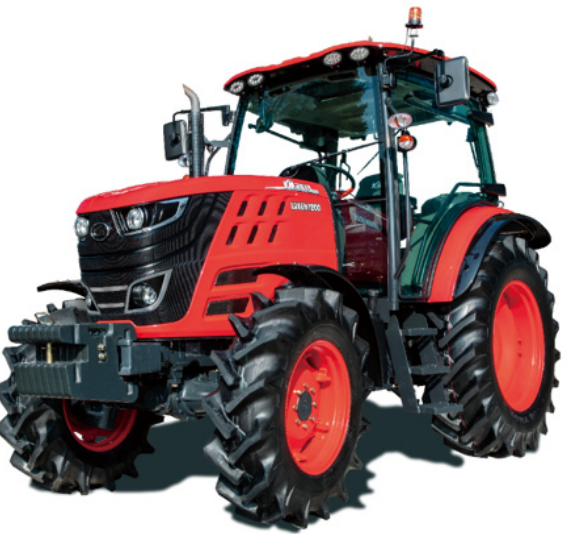
Figure 1. The 86 kW class agricultural tractor for the field test used in this study.